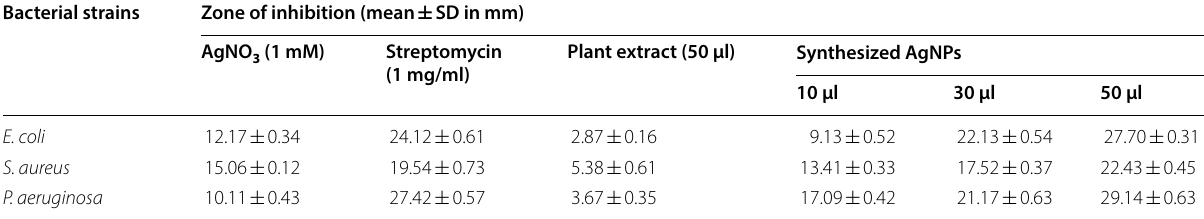
SD standard deviation